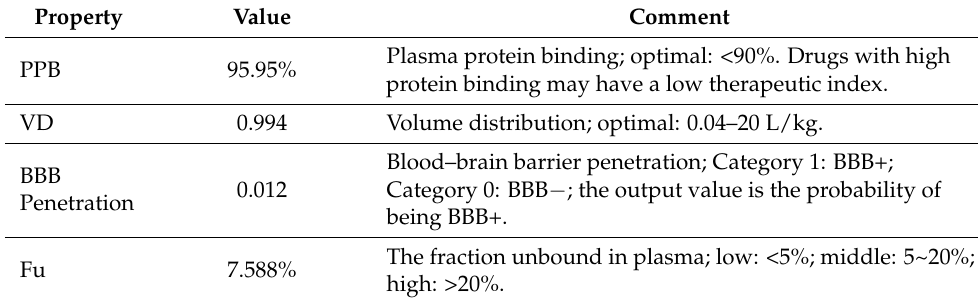
Table 9. The properties of the drug distribution of compound 1 .